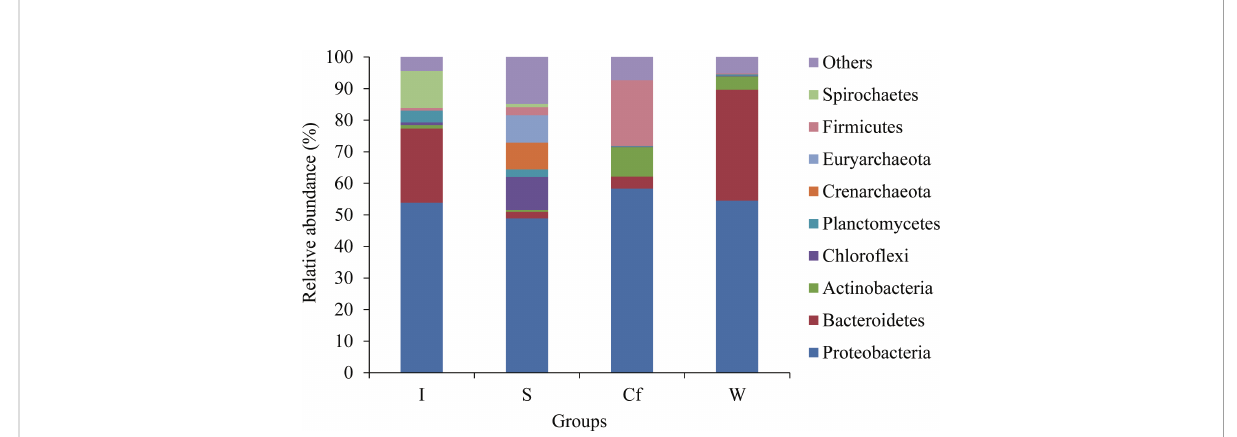
FIGURE 4 Relative abundance of phylum level bacterial communities in different samples.